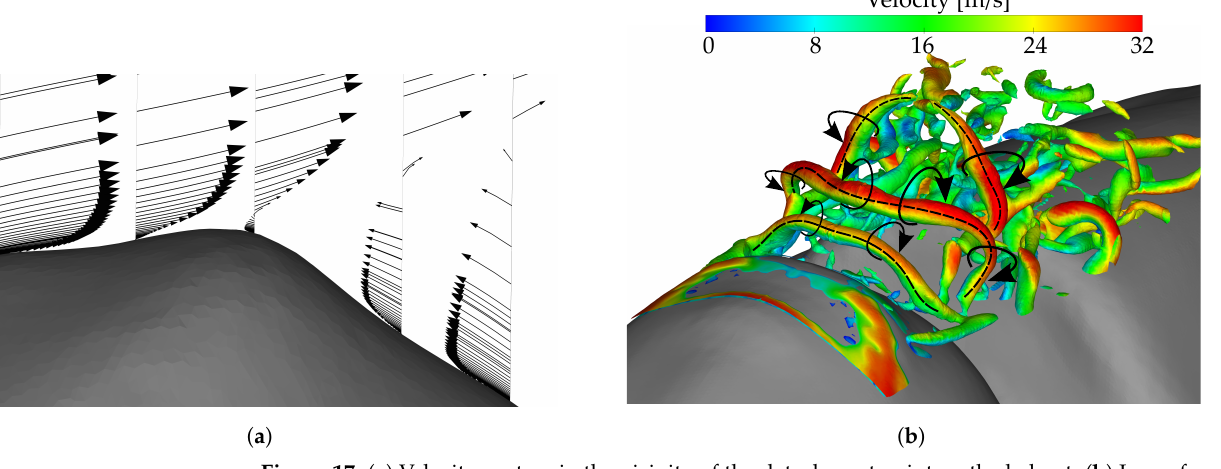
Figure 17. ( a ) Velocity vectors in the vicinity of the detachment point on the helmet. ( b ) Isosurface of Q-criterion equal to 3.5 × 10 6 1/s 2 coloured with velocity values and arrows indicating the direction of rotation of the